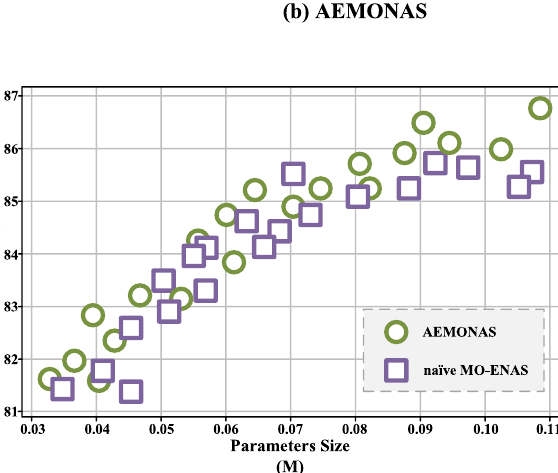
Fig. 9 Boxplot of the range of density values of all architectures in each generation population and curve change of architecture entropy values, where six generations of equal intervals are taken as an example. a and b are the diversity results of naive MO-ENAS and AEMONAS, respectively